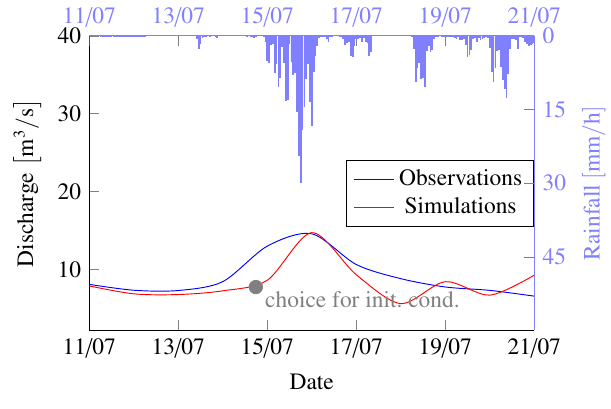
Figure 9. Simulation results compared to the observations for the period from 1 July to 31 July 2001 with indication of the moment for the chosen initial conditions for the PMP-PMF simulation.